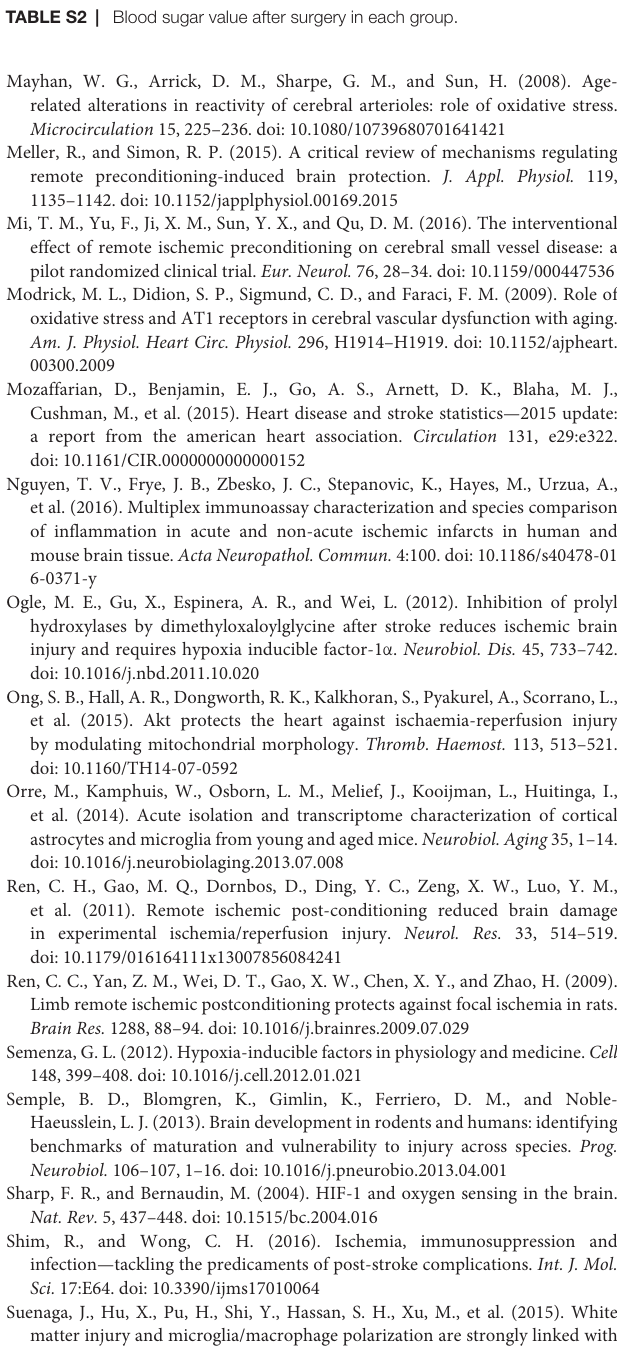
FIGURE S1 | Cerebral blood flow during the MCAo surgery. Cerebral blood flow was measured at four time-points, baseline, 1 and 5 min of ischemia and reperfusion in the MCAo, RIPC+MCAo and ACF+RIPC+MCAo groups. Data were normalized to baseline and expressed as percentages. FIGURE S2 | Images of TTC staining. All the panels and representative images of TTC staining were presented. (A) MCAo group. (B) RIPC+MCAo group. (C) ACF+RIPC+MCAo group. TABLE S1 | Arterial blood gas parameter before and immediately after MCAo. TABLE S2 | Blood sugar value after surgery in each